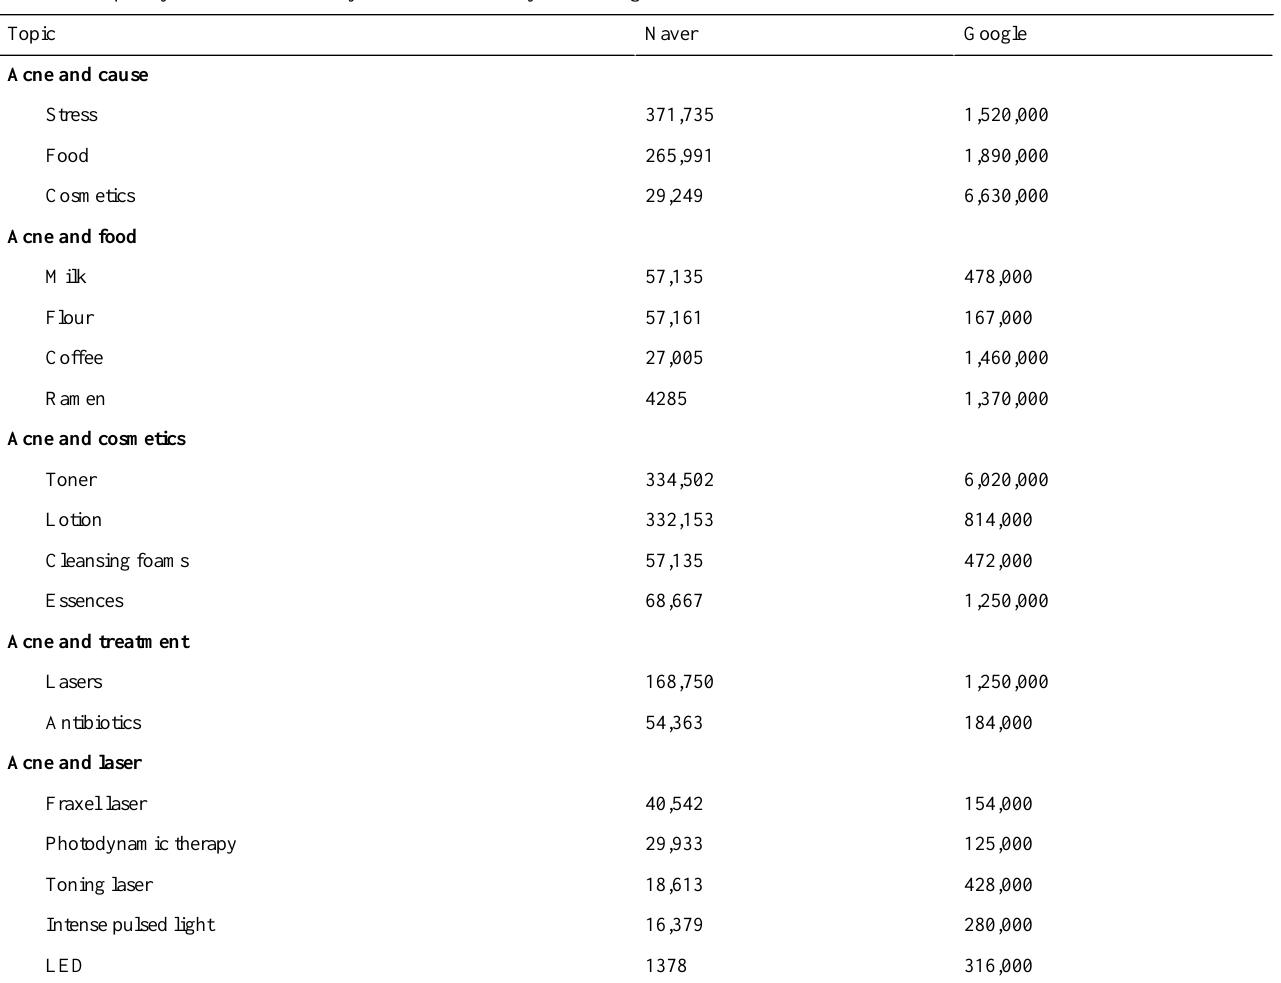
Table 3. Frequently searched relevant keywords determined by text